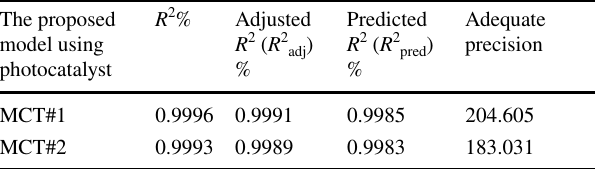
Table 3 Effective factors in the adequacy of the proposed models The proposed model using